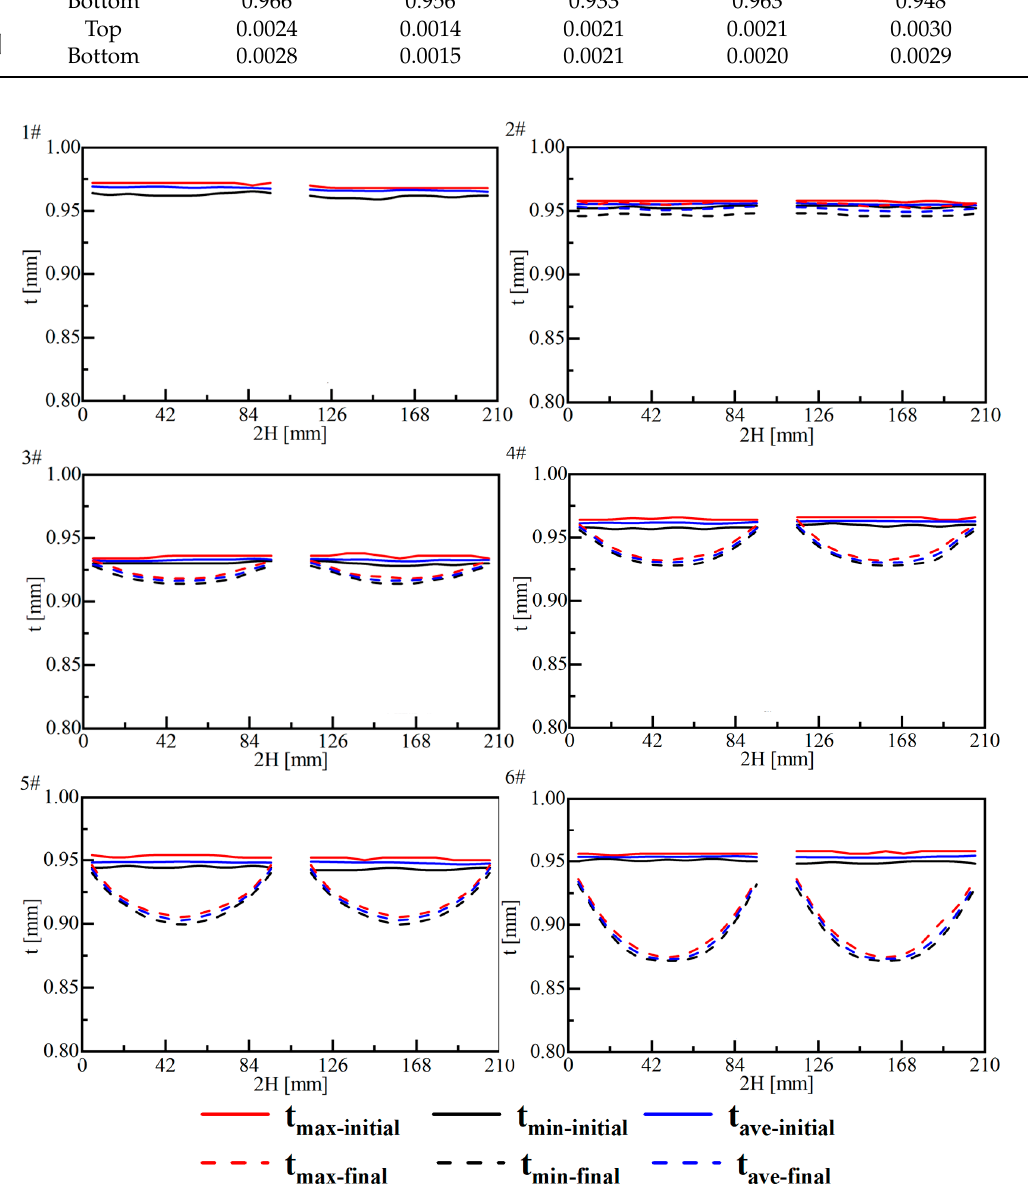
Figure 7. Thickness distributions of bi-segment cylindrical preforms (solid lines) and the corresponding bulged hulls (do tt ed lines).